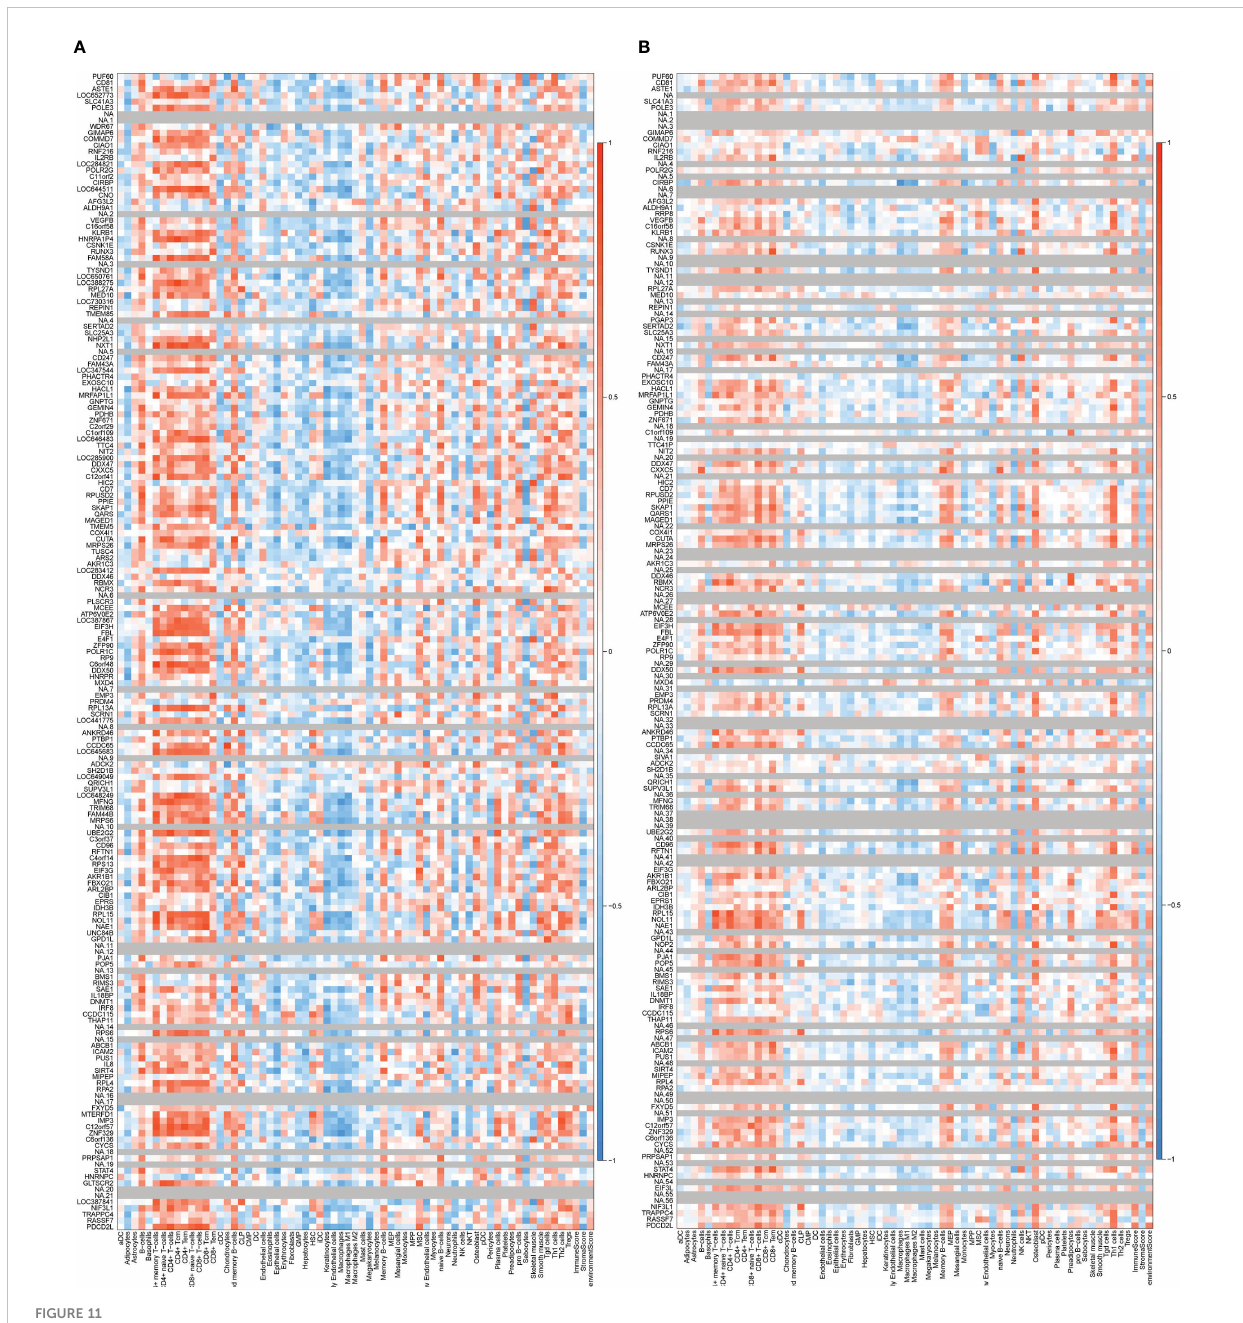
FIGURE 11 Correlation between down-regulated coDEGs and immune cells in validation datasets (A) Correlation between down-regulated coDEGs and immune cells in AS (GSE25101). (B) Correlation between down-regulated coDEGs and immune cells in IBD (GSE94648). (Gray means that the gene was not probed in this